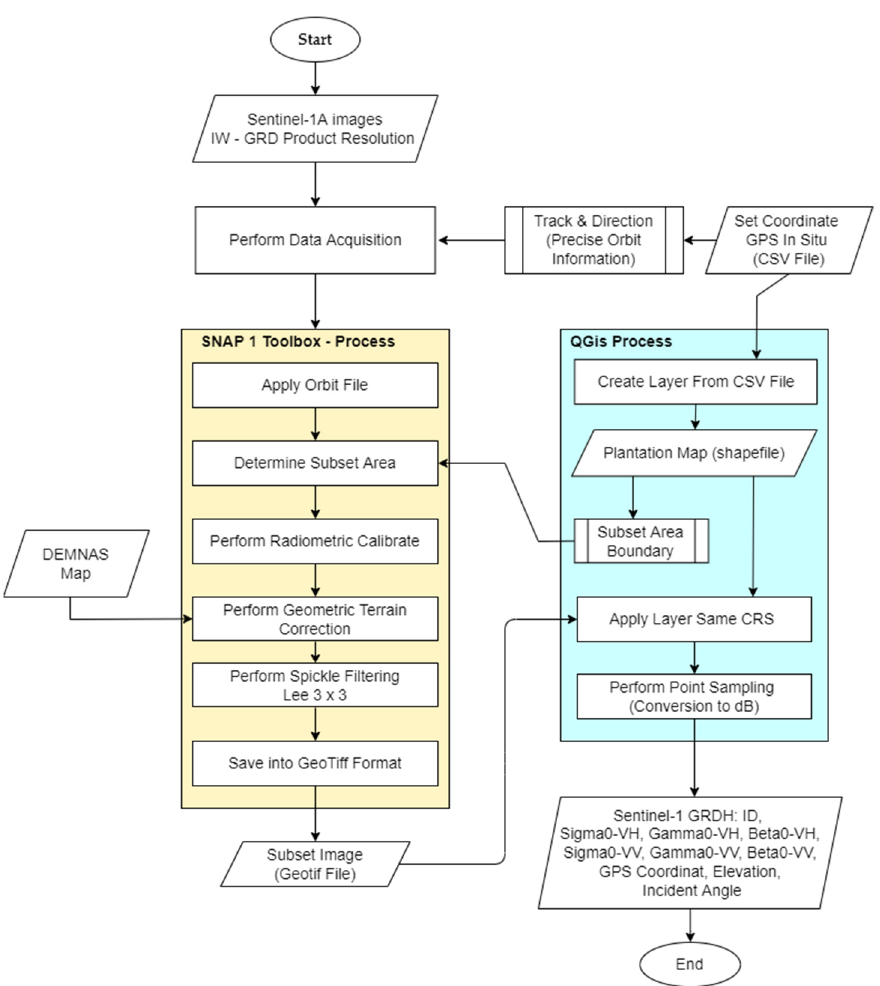
Figure 5. The steps of data preprocessing and feature extraction.